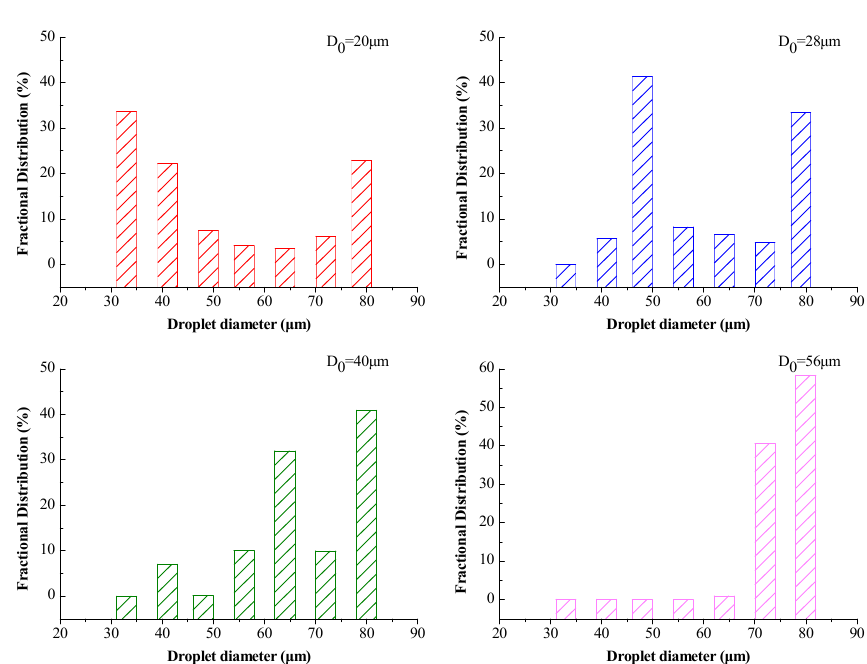
Figure 9. The influence of initial diameter on oil droplet size distribution when the air inflow is 12 g/s and the oil inflow is 15 g/s at t = 250 ms.